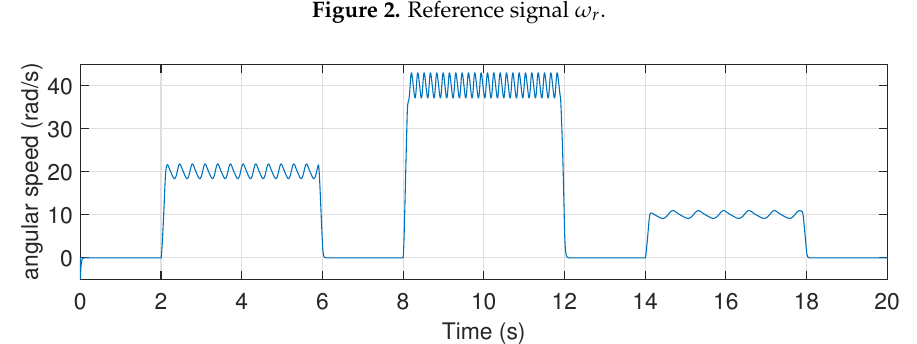
Figure 2. Reference signal ω r .